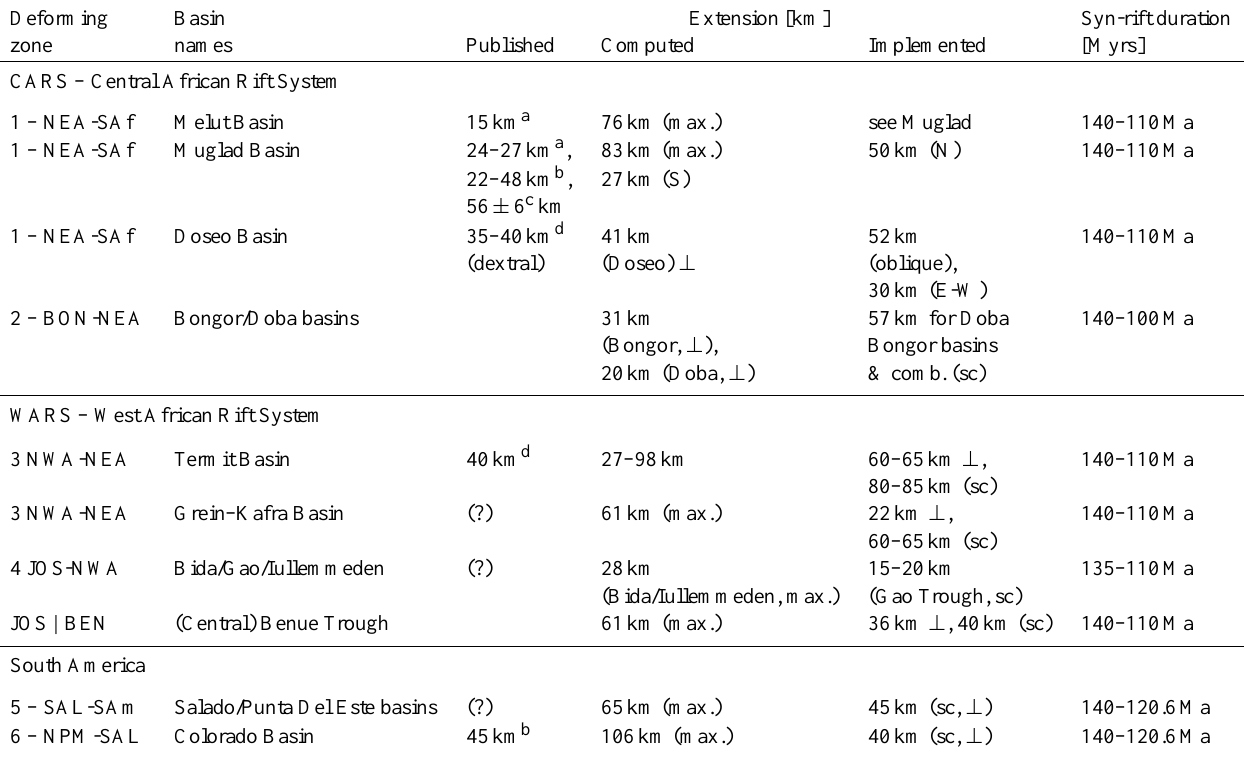
Table 1. Deformation estimates used for major intraplate deformation zones. “Computed” extension is based on the our method as described in Sect. 2 and represents a maximum estimate as it is based on total sediment thickness, always measured orthogonal to major basin/rift axis. “Implemented” deformation is actual displacement as implemented in plate kinematic model. Integers in column “Deforming zone” refer to plate circuit (Fig. 9); abbreviations refer to plate pairs. ⊥ : extension measured orthogonal to long rift/basin axis; sc: along small circle around corresponding stage